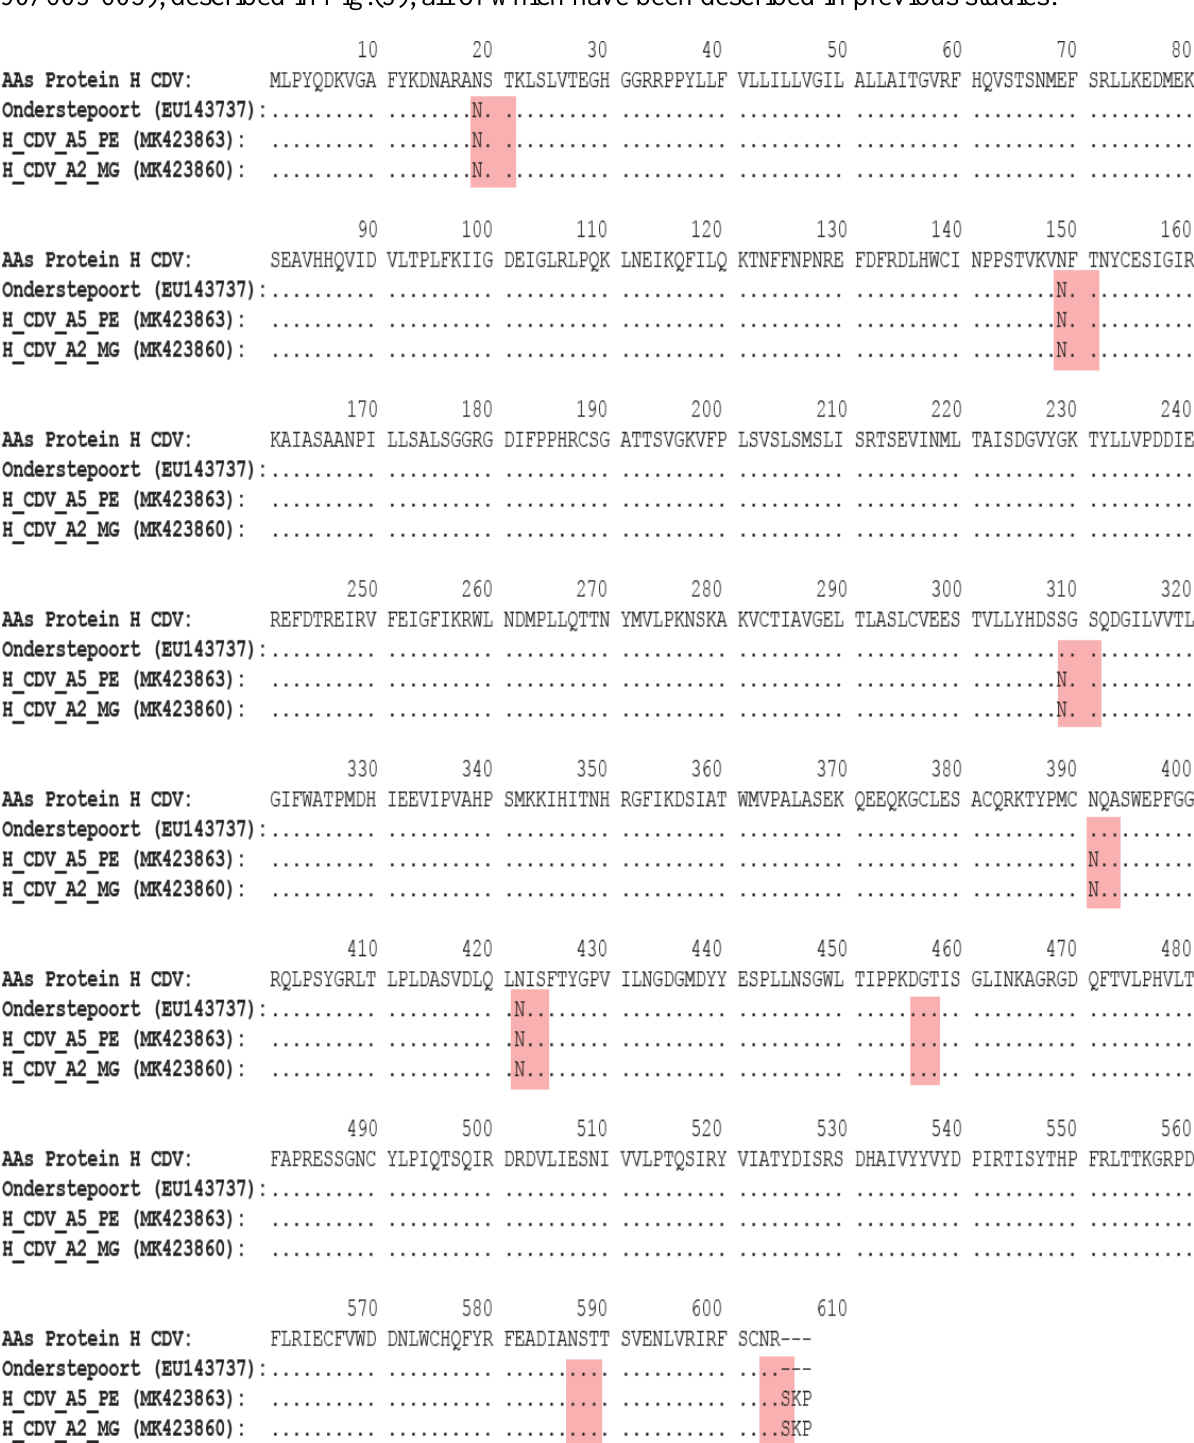
Fig. 3: Prediction of N-glycosylation sites from alignment of deduced amino acid sequences of protein H from newly described sequences and from CDV vaccine strain. Alignment of the amino acid sequence of the CDV H protein of the vaccine strain “Onderstepoort” (EU143737) and two new Brazilian isolates described in this study: H_CDV_A5_PE (MK423863) and H_CDV_A2_MG (MK423860). The pink region represents the areas associated with potential N-glycosylation sites (N-X-S/T). The dots (.) refer to